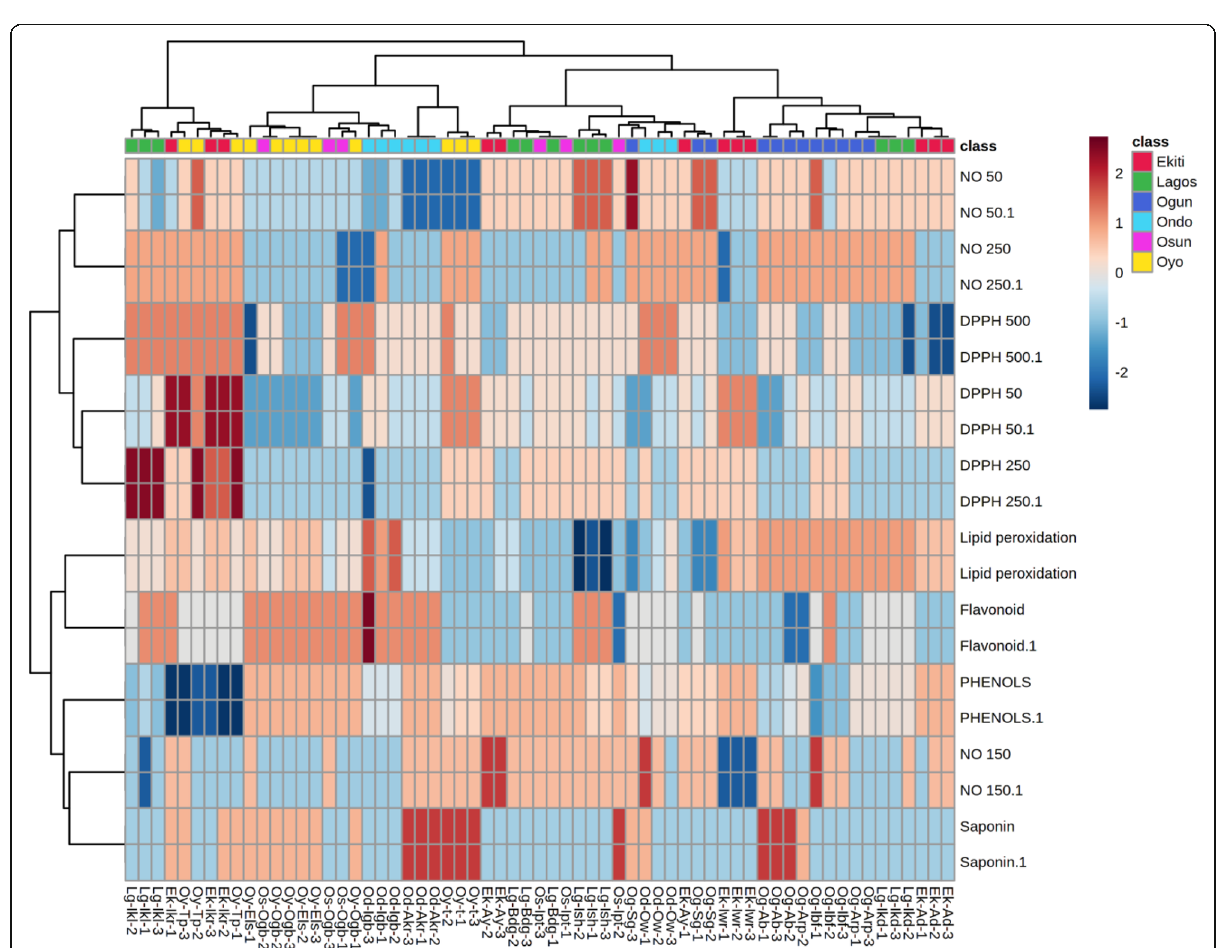
Fig. 11 Heat map of the results with significance. The heat map revealed at a glance the pattern of differences of the parameters checked between the different groups from different